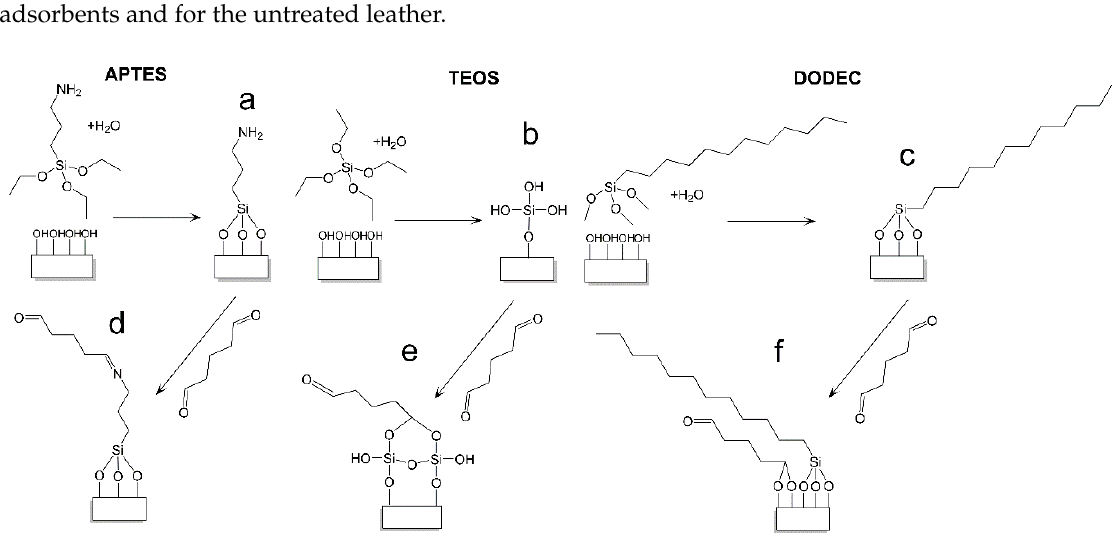
Figure 4. FTIR spectra of APTES ( a ), TEOS ( b ) and DODEC ( c ) for Leather (-), Leather functionalized with a silane ( … ) and leather functionalized with a silane and glutaraldehyde ( -- ) . Figure 5 shows the SEM images of untreated leather (a), functionalized leather with silanes (b, c and d) and functionalized leather with silanes and glutaraldehyde (e, f and g). Morphological changes between functionalization steps can be observed, while smoother surfaces can be appreciated after adding glutaraldehyde, probably due to the cross-linking properties of the molecule.